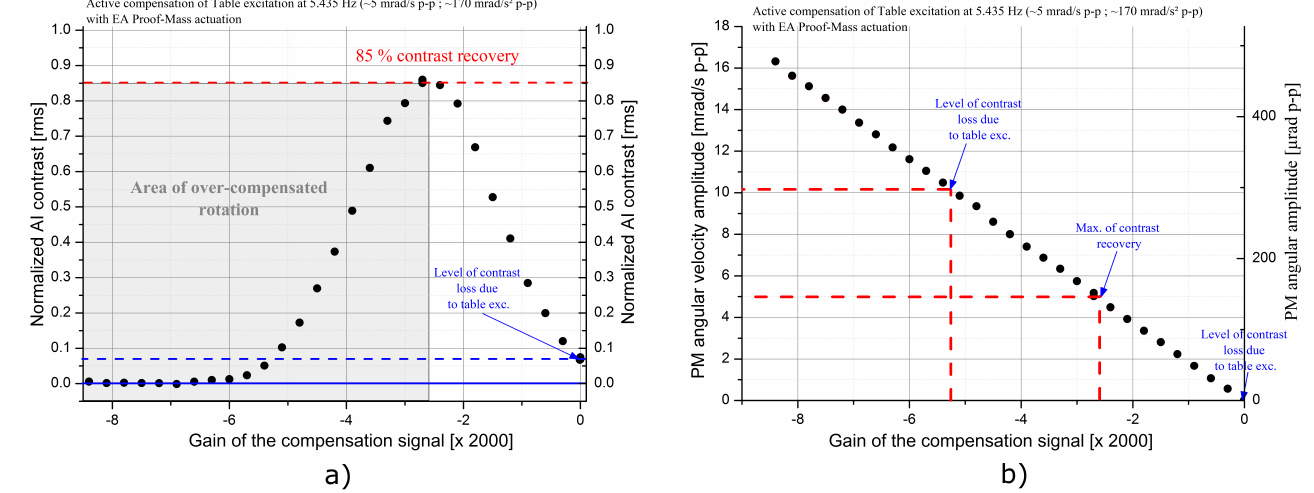
Figure 20. ( a ) Active rotation compensation impact on the CAI contrast for a platform excitation at 5.435 Hz. The variation of the CAI contrast is reported according to the gain amplitude of the compensation signal. ( b ) PM angular velocity amplitude (left axis) and angular amplitude (right axis) according to the compensation gain. For 0 gain, the proof-mass is not moved and the CAI contrast loss is only due to platform rotation. For a gain of ≈− 2.6 ( × 2000), the CAI contrast is retrieved at a maximum of ≈ 85%. For a gain of ≈− 5.3( × 2000), the atomic contrast returns to a value similar to that obtained with only the platform excited and the PM motionless.